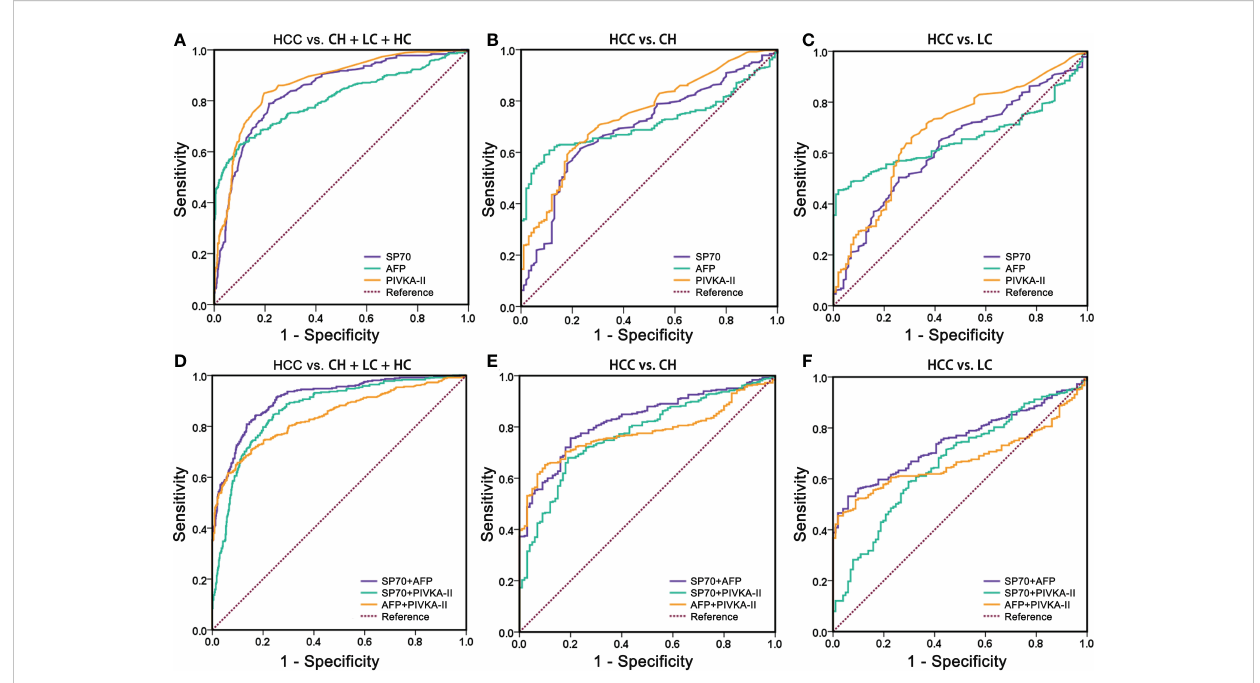
FIGURE 3 Comparison of receiver operating characteristics curves of SP70, AFP, PIVKA-II and three different multi-marker combinations. (A, D) HCC vs. BLD + HC; (B, E) HCC vs. BLD; (C, F) HCC vs. LC. BLD, benign liver diseases; HC, healthy control; LC, liver